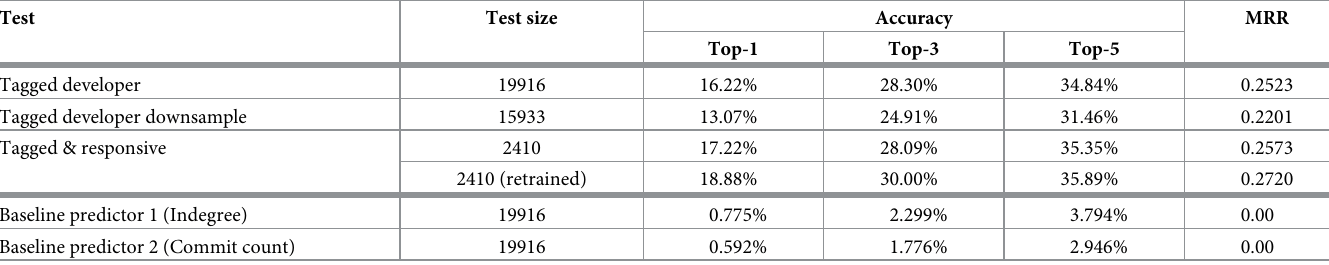
Table 5. Recommendation accuracy on the committer-only